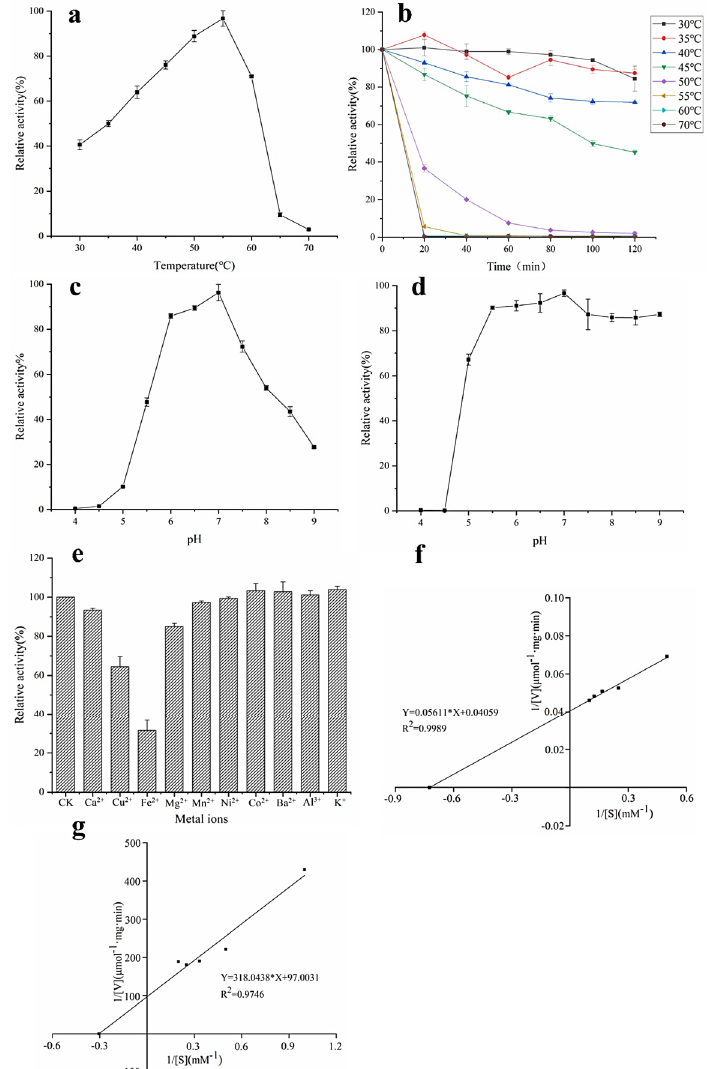
Figure 3. Properties of α -L-rhamnosidase. ( a ) Optimum temperature, ( b ) thermal stability, ( c ) optimum pH, ( d ) pH stability, ( e ) effects of metal ions, ( f ) kinetic parameters with pNPR as substrate, and ( g ) kinetic parameters with epimedin C as